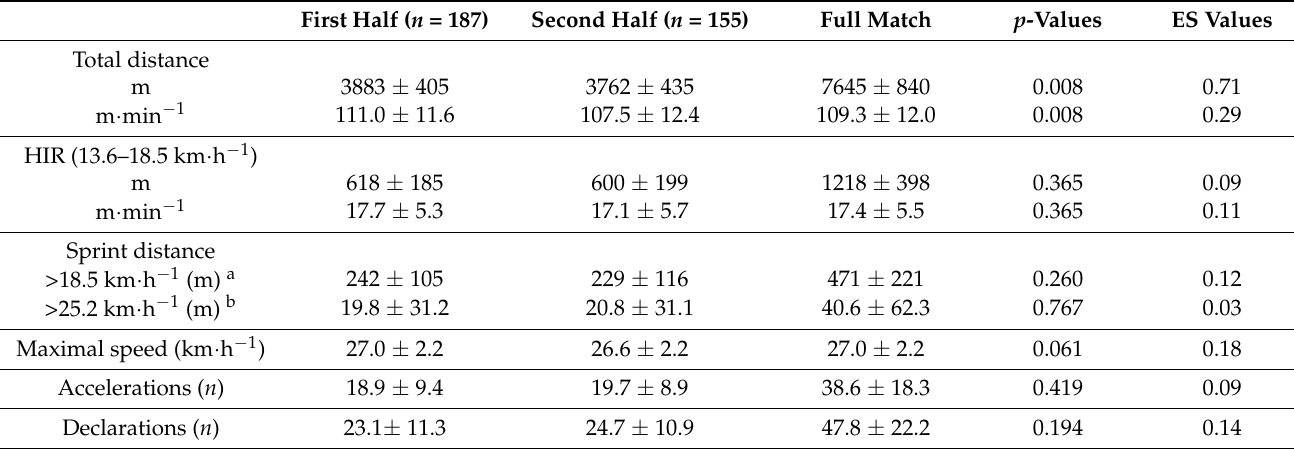
Table 1. An overview of total match distance covered and high-intensity actions in Norwegian U14 players. Data are presented as means ± SD. Match playing time was 2 × 35 min. One-way ANOVA was used when comparing match halves independently of whether the same players played one or both